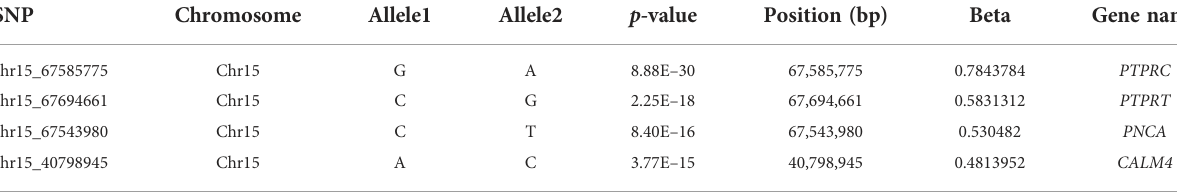
Allele1, minor allele; Allele2, major allele; Beta, effect size of each